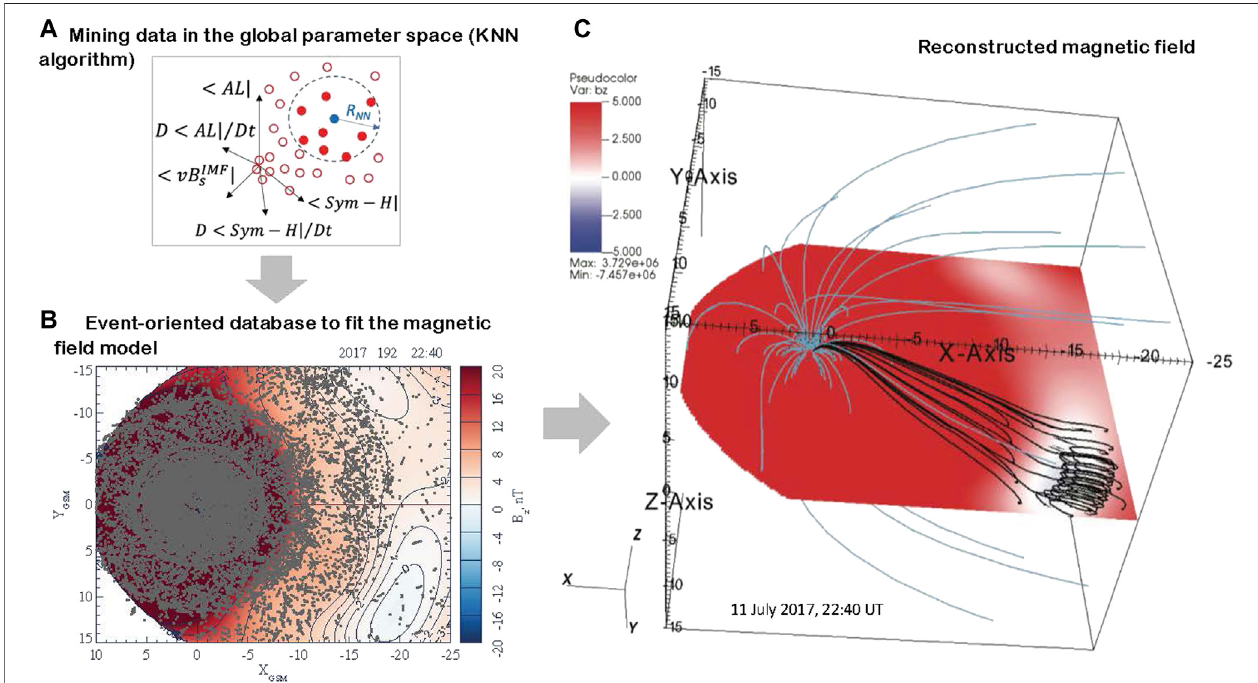
FIGURE1| DM algorithmofthemagnetic fi eldreconstruction usedinthisstudy: (A) Nearestneighborselectionusing KNNmethod. (B) Theevent-orientedsubset of the database formed using the selected set of K NN nearest neighbors. It is used to fi t the magnetic fi eld model. Gray dots show the projections of the spacecraft coordinatesontheequatorialplane,wherethenormalmagnetic fi eldcomponent B z iscolorcoded. (C) Theresultingmagnetic fi eldlines(black)andtheequatorial fi eld B z (color-coded) assuming zero tilt angle (adapted from [27]).